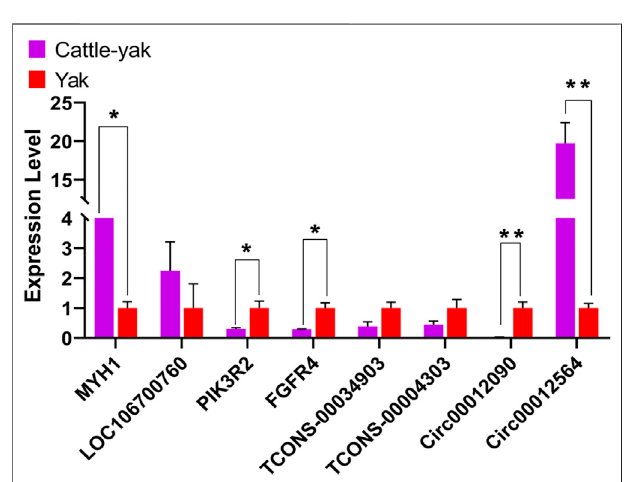
FIGURE6| Theresultsofthereal-timequantitativePCRvalidationofthe expression level. ** indicates p < 0.01, * indicates p < 0.05. The data represented the mean ± SEM from three biological replicates, and each measurement was repeated 3